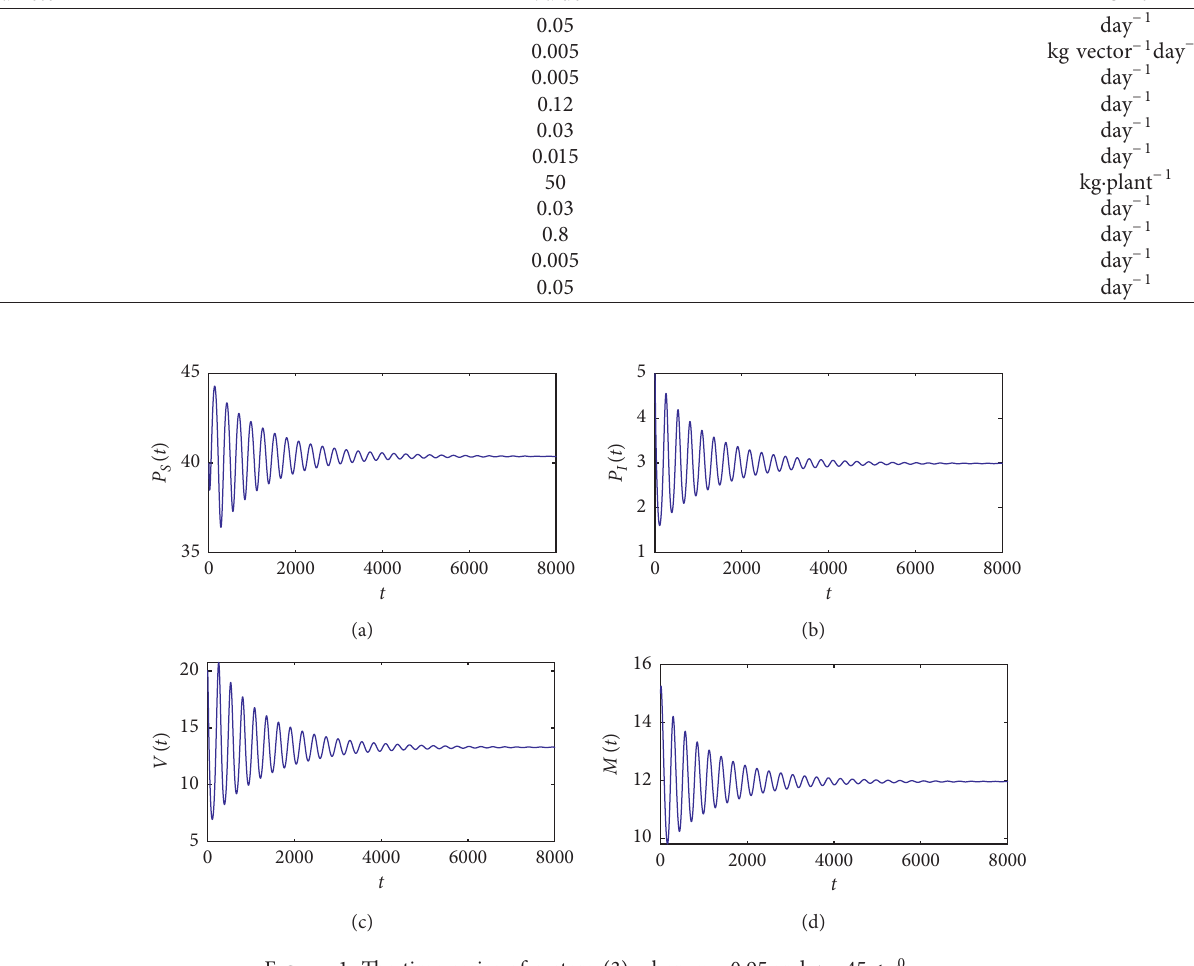
Figure 1: The time series of system (3) when α � 0 . 95and τ � 45 < τ 0 .